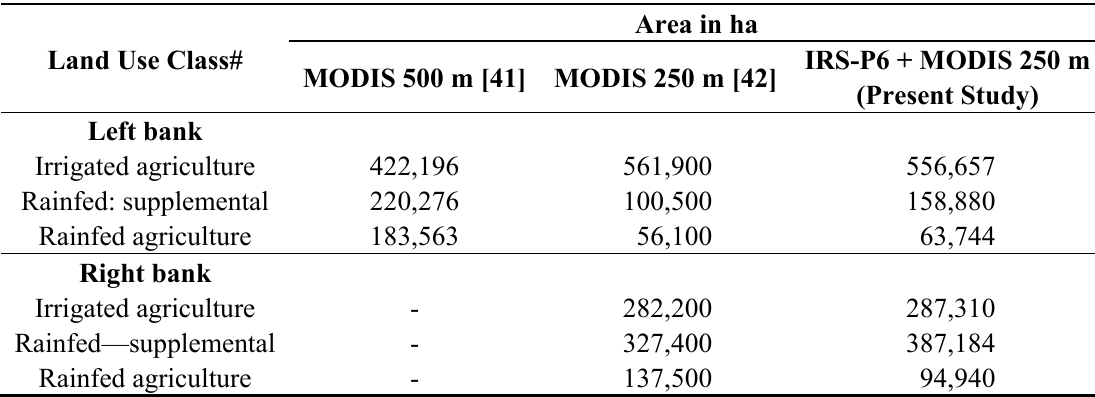
Table 4. Comparison of irrigated areas from various